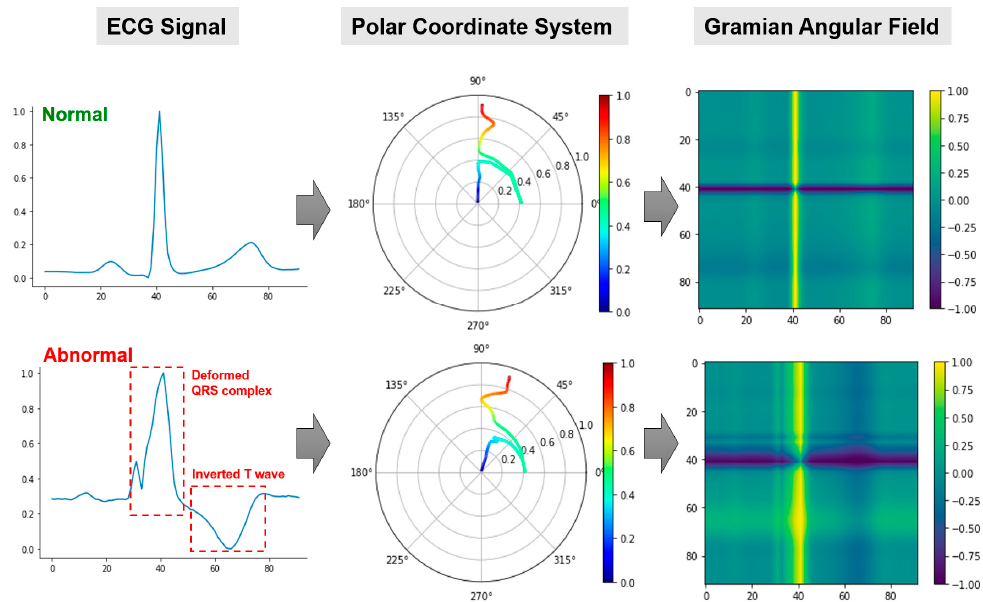
Figure 2. The construction of GADF images from 1D ECG signals. Left column: rescaled ECG signals; middle column: projected ECGs in the polar coordinate system; and right column: obtained 2D GADF images.